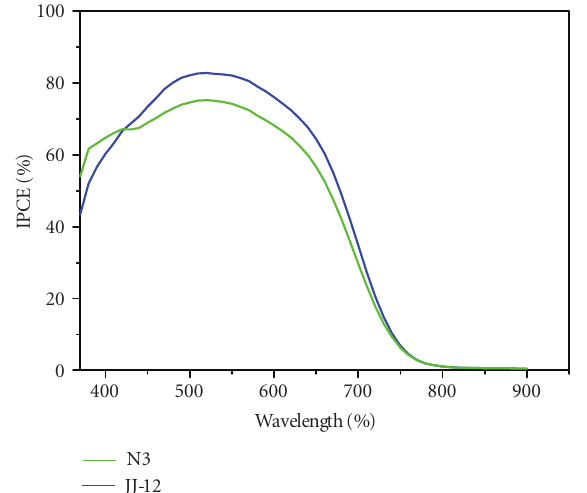
Figure 3: IPCE of JJ-12 (blue line) and N3 (green line).